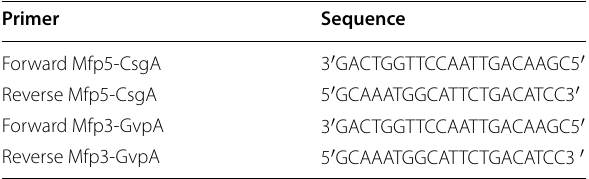
Table 2 Oligonucleotide sequences designed as the and reverse primers for the Mfp5-CsgA and Mfp3- GvpA